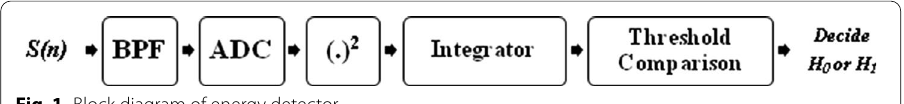
Fig. 1 Block diagram of energy